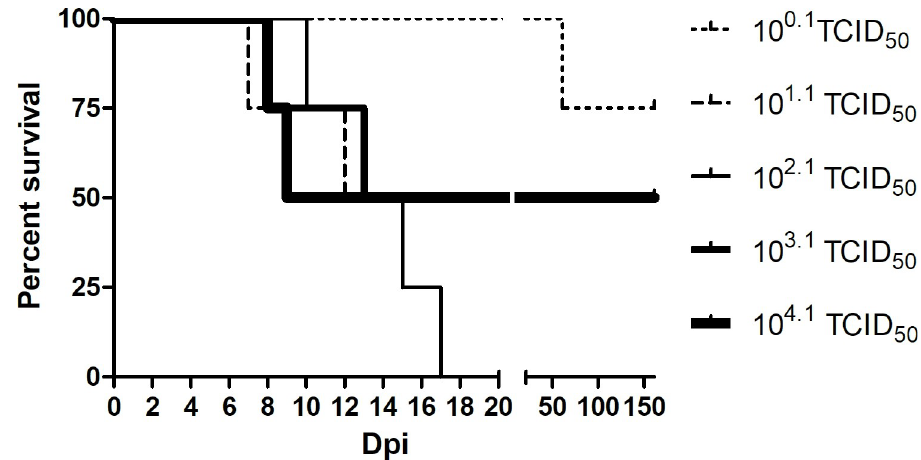
Fig 1. Survival per inoculation group (n = 4 bats) over time, showing 100% mortality in the middle dose (10 2.1 TCID 50 ) group.